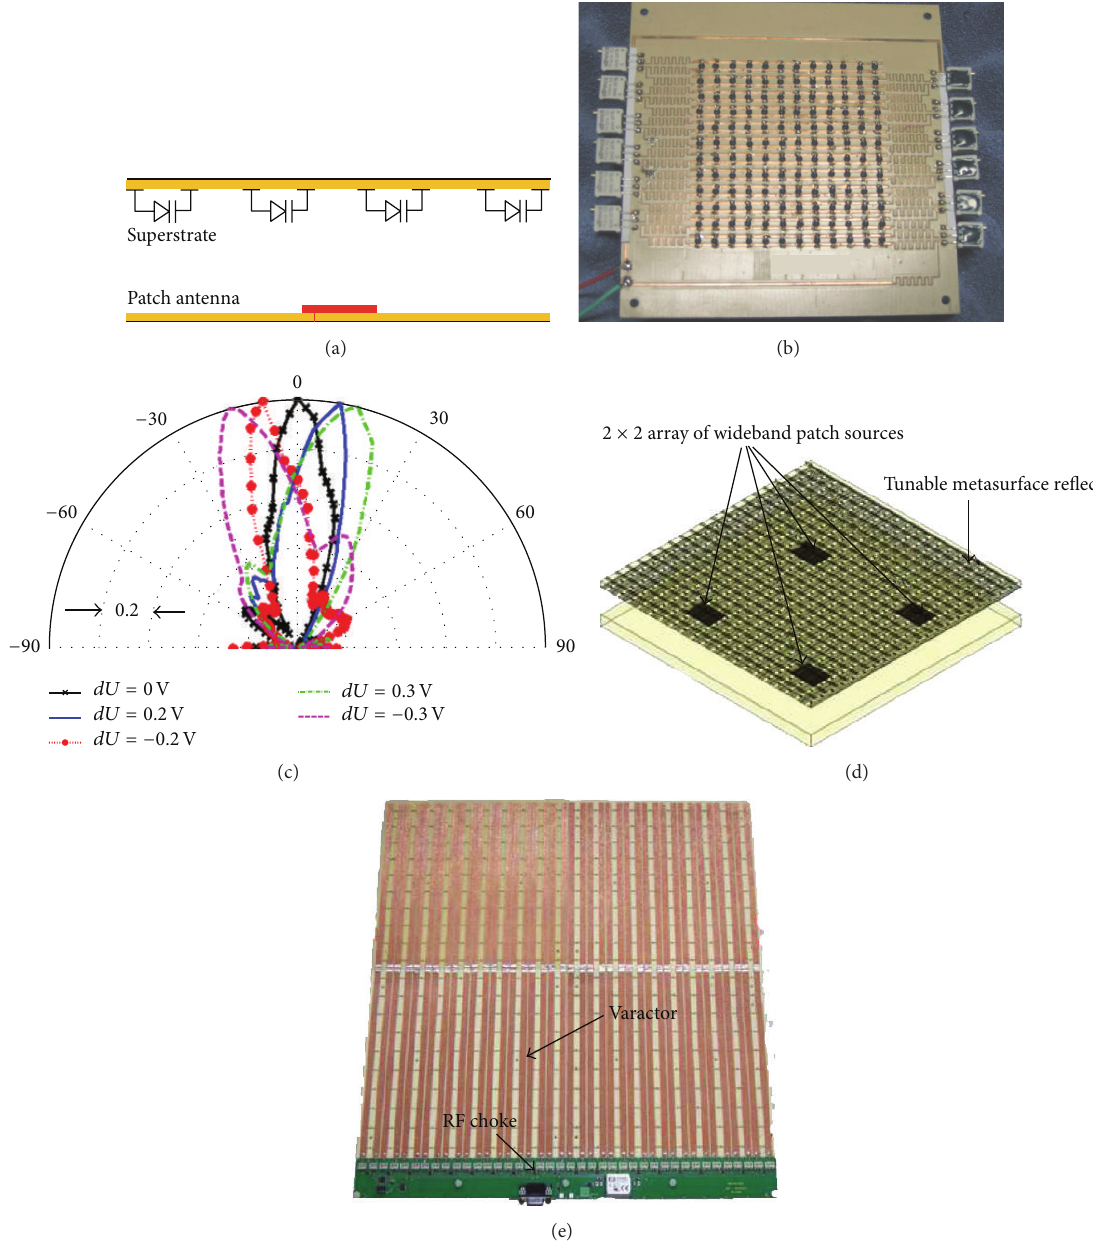
Figure 5: (a) Schematics of the cavity composed of a perfect-electric conductor (PEC) and an electronically phase varying partial reflection surface; (b) the prototype photo showing the capacitive grid side with biasing network; and (c) the measured gain patterns under different biasing condition [55] (reproduced by permission of the Institution of Engineering & Technology). (d) A generalized cavity with 2×2 antenna array excitation and (e) the system equipped with biasing network [56, 57] (reproduced by permission of John Wiley and